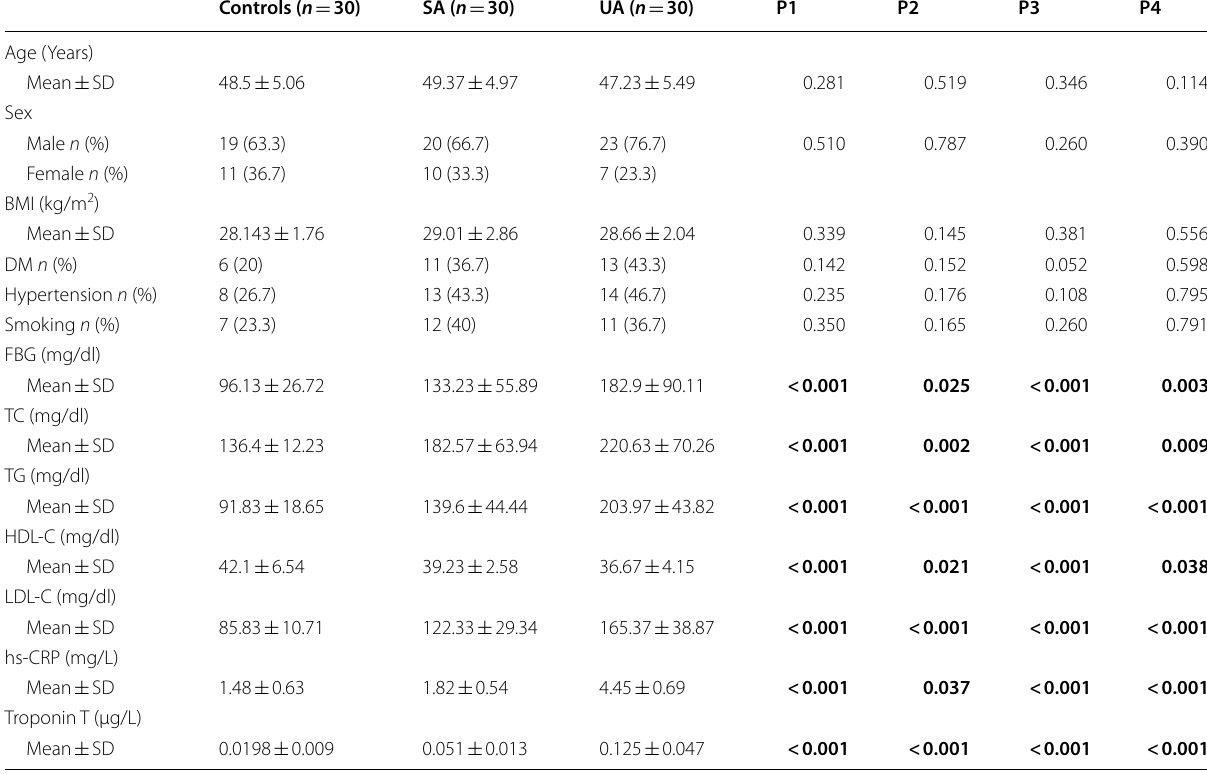
Table 1 Demographic, clinical, and biochemical characteristics of participants